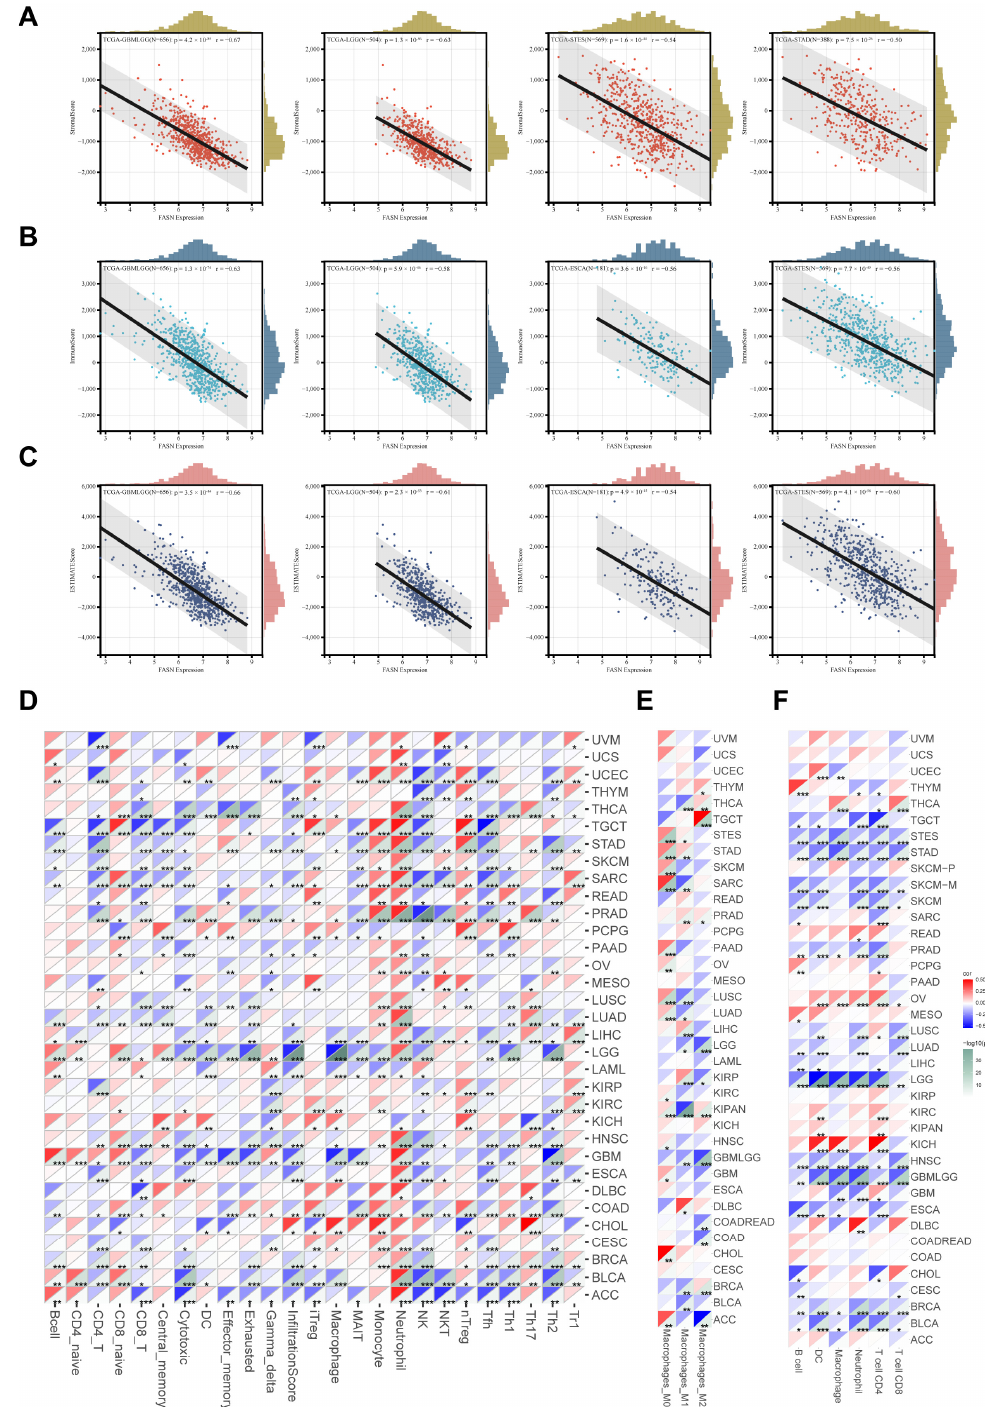
Figure 4. Correlations between FASN expression and immunity infiltration. ( A ) The top four tumors with the most significant correlation between the degree of immune infiltration and FASN expression were GBMLGG, LGG, STES, and STAD (StromalScore); ( B ) GBMLGG, LGG, ESCA, and STES (Im- muneScore); ( C ) GBMLGG, LGG, ESCA, and STES (ESTIMATEScore). ( D ) The correlation between FASN expression and 24 kinds of immune cell infiltration was analyzed by ImmuCellAI. ( E ) Sanger- box3.0 online website was used to analyze the relationship between FASN mRNA expression and M0 Macrophage, M1 Macrophage and M2 Macrophage infiltration. ( F ) Timer examined the correlation between FASN expression and six types of immune cell infiltration. (* p < 0.05, ** p < 0.01, *** p <